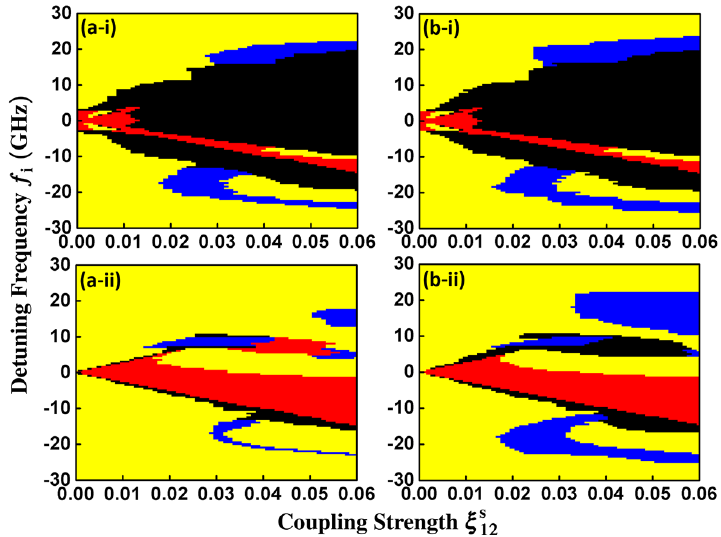
Figure 3. Maps of dynamical states for ( a ) LD1 and ( b ) LD2, respectively, in the mutually coupled laser system when ( i ) ξ s = 0.01 and ( ii ) ξ s = 0.001. Regions of mutual injection locking, P1 dynamics, 21 21 P2 dynamics, and chaos are marked by red, yellow, blue, and black,